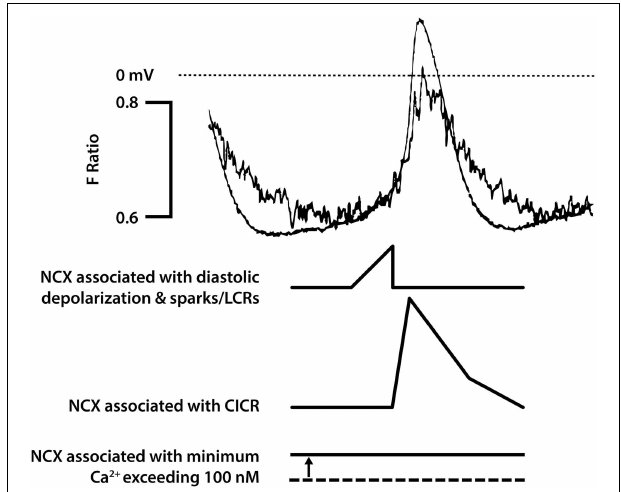
FIGURE 2 | This figure seeks to show in cartoon form the various contributions of NCX to pacemaker activity [that are not confined just to rises in subsarcolemmal Ca 2 + associated with spontaneous Ca 2 + release from the SR described as Ca 2 + sparks or local calcium release events (LCRs)]. The magnitude of the NCX currents will broadly follow the magnitude of the Ca 2 + transient (though if there are sufficient changes in subsarcolemmal Ca 2 + and Na + , these changes will influence the equilibrium potentials for these ions and therefore the driving force for NCX). The time course of the Ca 2 + transient as reported by the Ca 2 + probe indo-1 (fluorescence ratio with emission at 405 and 485nm) is shown overlaid with an action potential in a pacemaker cell in the upper pair of traces. It is recognized that the indo-1 fluorescence ratio (noisy trace) will show a lag as a consequence of the kinetics of Ca 2 + binding to the probe, and there may be a delay in the decline in Ca 2 + as a consequence of slow dissociation of Ca 2 + from the probe (although this delay seems not to be severely limiting since isoprenaline was able to speed the Ca 2 + signals recorded with this probe, see Figure 5 ). There is a rise in Ca 2 + that precedes the rapid upstroke of the action potential, and under conditions in which spontaneous Ca 2 + sparks/LCRs occur these events will contribute to the early phase of NCX. This is followed by CICR triggered by Ca 2 + entry largely through I CaL , and the accompanying large rise in subsarcolemmal Ca 2 + will be associated with a substantial additional component of NCX. It is thought that the cytosolic and subsarcolemmal Ca 2 + concentrations remain greater than 100nM even at the most negative membrane potential between action potentials and this is associated with the third component of NCX represented in the bottom trace, with a dotted line to represent zero NCX current that would be expected to occur at approximately 100nM Ca 2 + . Although the components of NCX are shown as separate in this diagrammatic representation to emphasize the many roles of NCX, it is recognized that in reality these components run together as a continuum and cannot easily be dissected experimentally. In addition to these three components of electrogenic NCX with a 3 Ca 2 + :1 Na + stoichiometry, there may be an additional “leakage” component (see text). The experimental traces are from Rigg et al.